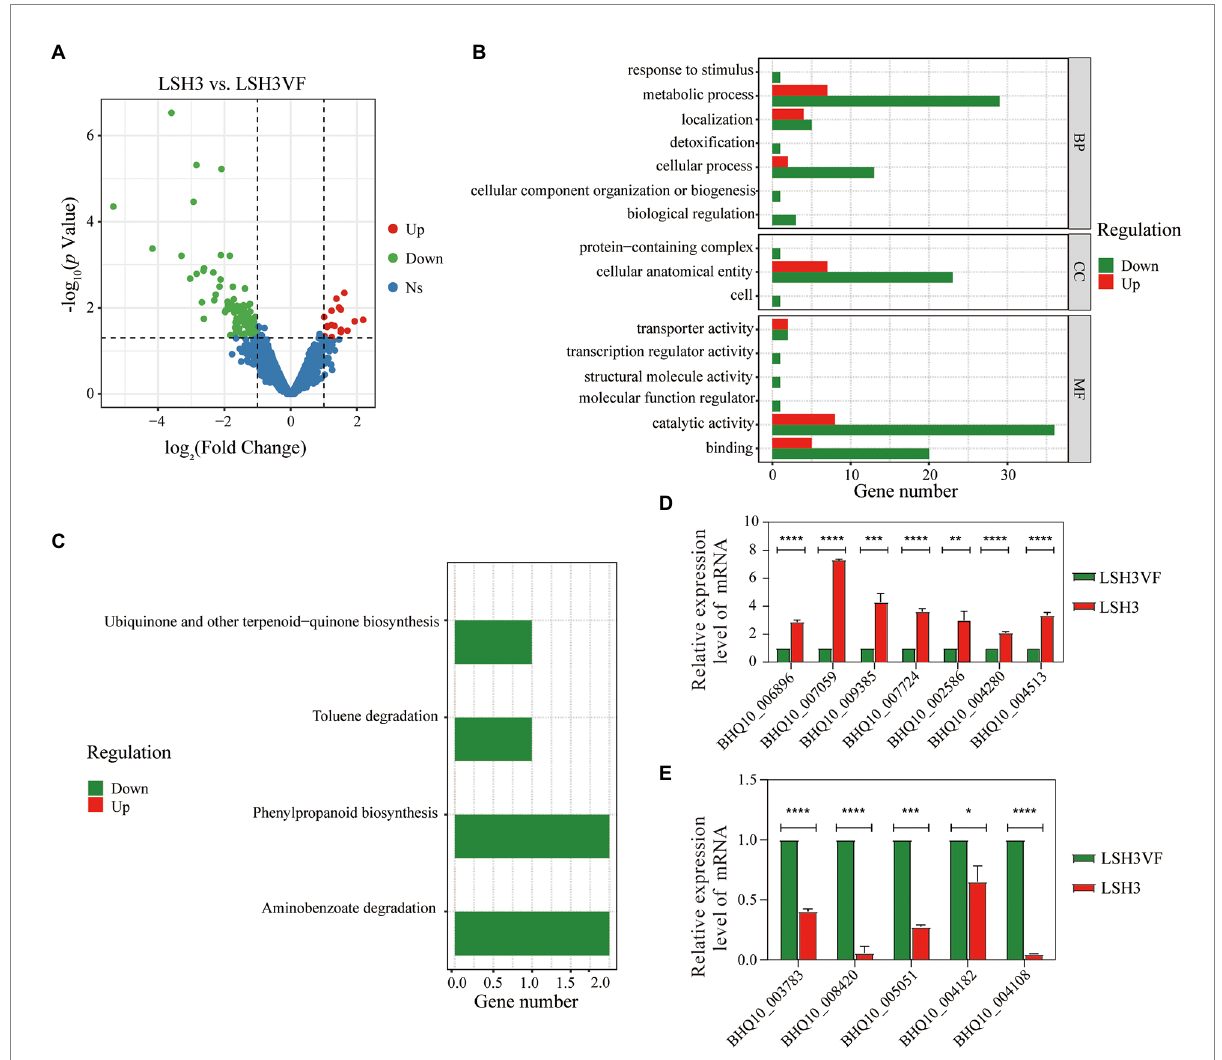
FIGURE 4 (A) Comparison of the profiles of the DEGs of the virus-infected strain with those of uninfected T. amestolkiae . (B,C) The clusterProfiler package in R was used for GO enrichment analysis, and KEGG enrichment analysis of the DEGs. (D,E) RT-qPCR analysis of the upregulated and downregulated